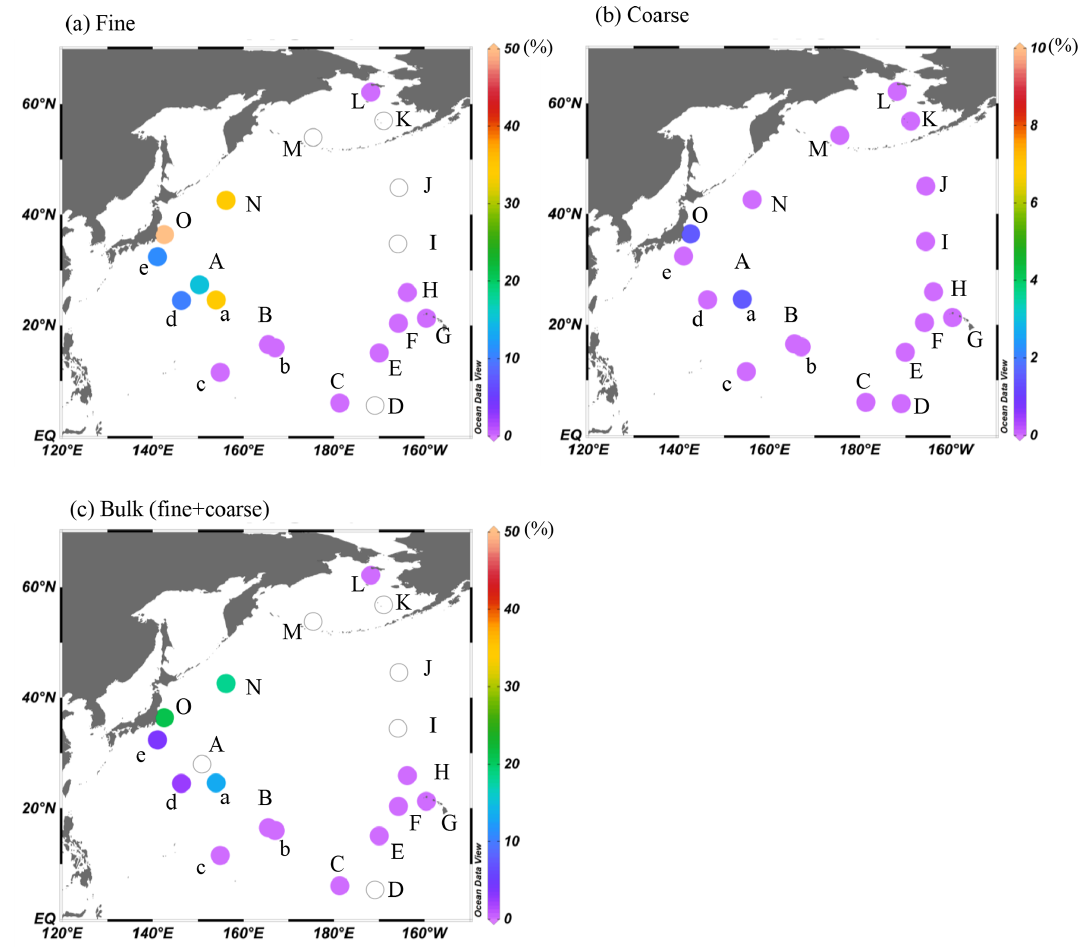
Figure 9. The contribution of combustion Fe to (a) fine, (b) coarse, and (c) total (fine + coarse) Fe in marine aerosols. Data with open circles were not determined. The figures were produced using Ocean Data View (Schlitzer,